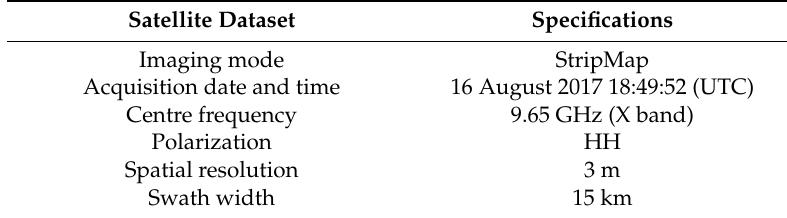
Table 2. Description of the TerraSAR-X synthetic aperture radar (SAR) image [46] used for comparison with the mosaicked helicopter-borne image.